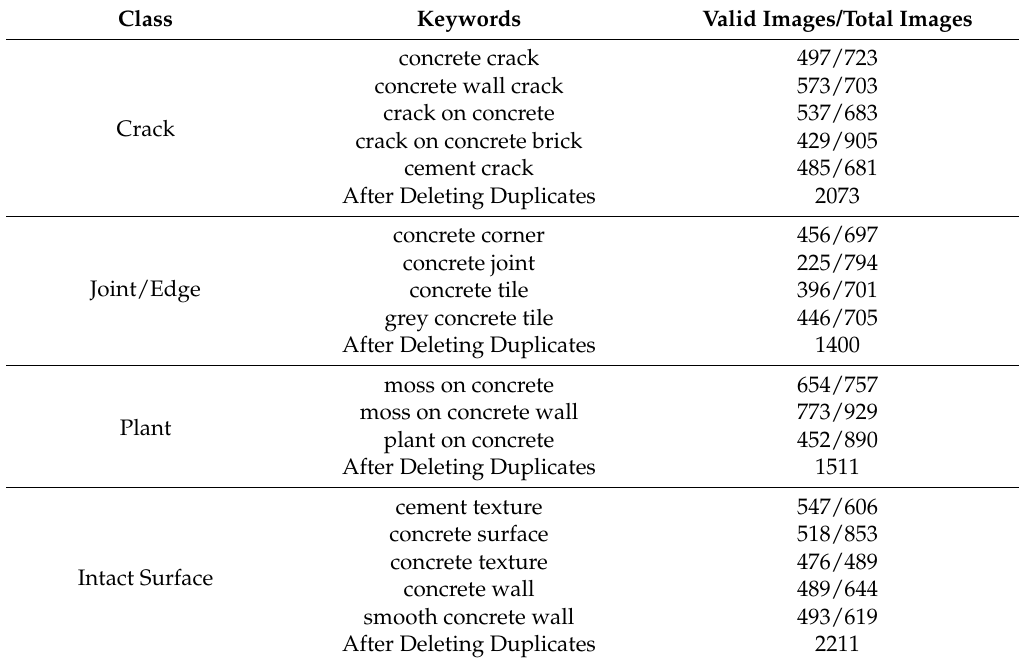
Figure 2. Examples of ( a ) valid and ( b ) invalid images scraped by the keyword “concrete crack”. Table 1. Number of valid images scraped from the